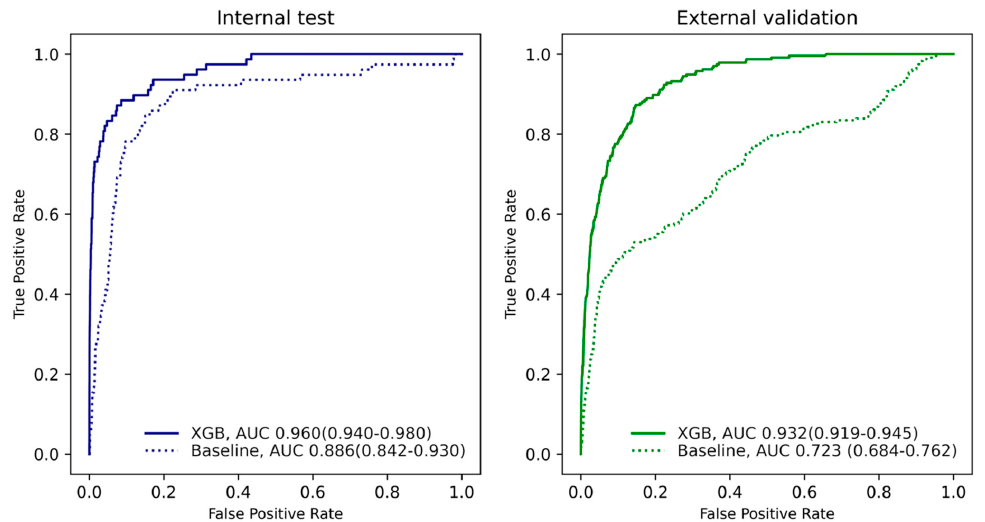
Figure 2. AUROC (area under the receiver operating characteristic curve) and AUPRC (area under the precision and recall curve) plots in the internal validation test set (Samsung medical center) and external validation dataset (Ajou university medical center). XGB (extreme gradient boosting algorithm) denotes the main model of our study based on various variables from preoperative evaluation sheets. Baseline denotes logistic regression model with only sex, age, weight, height, American Society of Anesthesiologists (ASA) class, and underlying disease.